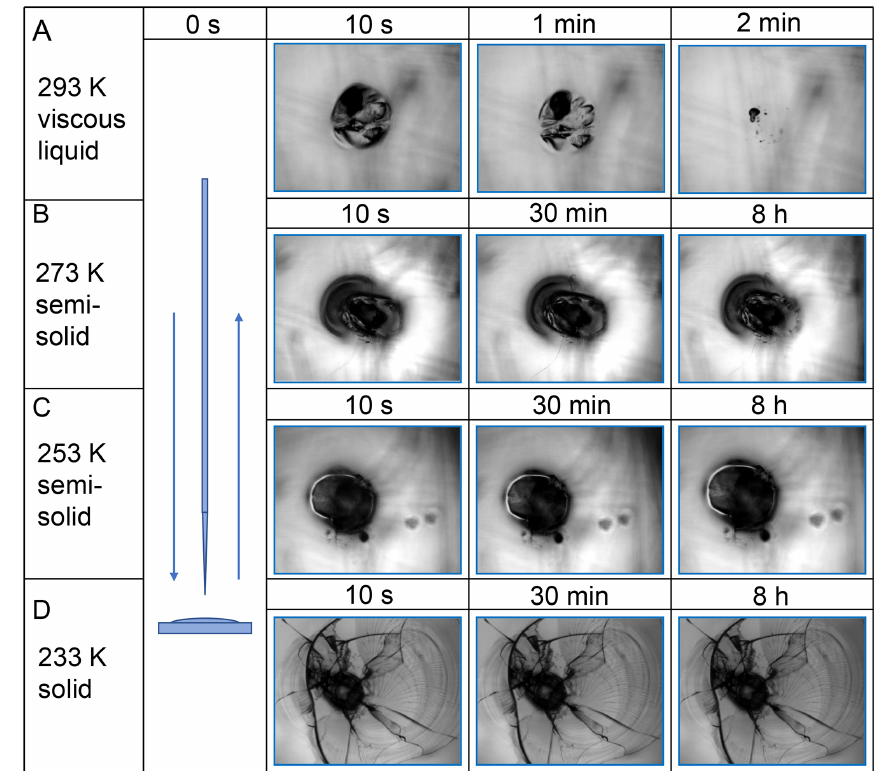
Figure 3. Estimation of the phase state of the film substrate as shown for a GLU/HEX mixture (mass ratio of 4 : 1). Deformation and recovery were monitored for different time periods due to the poking of the substrate at different temperatures. The microscope images are 200µm